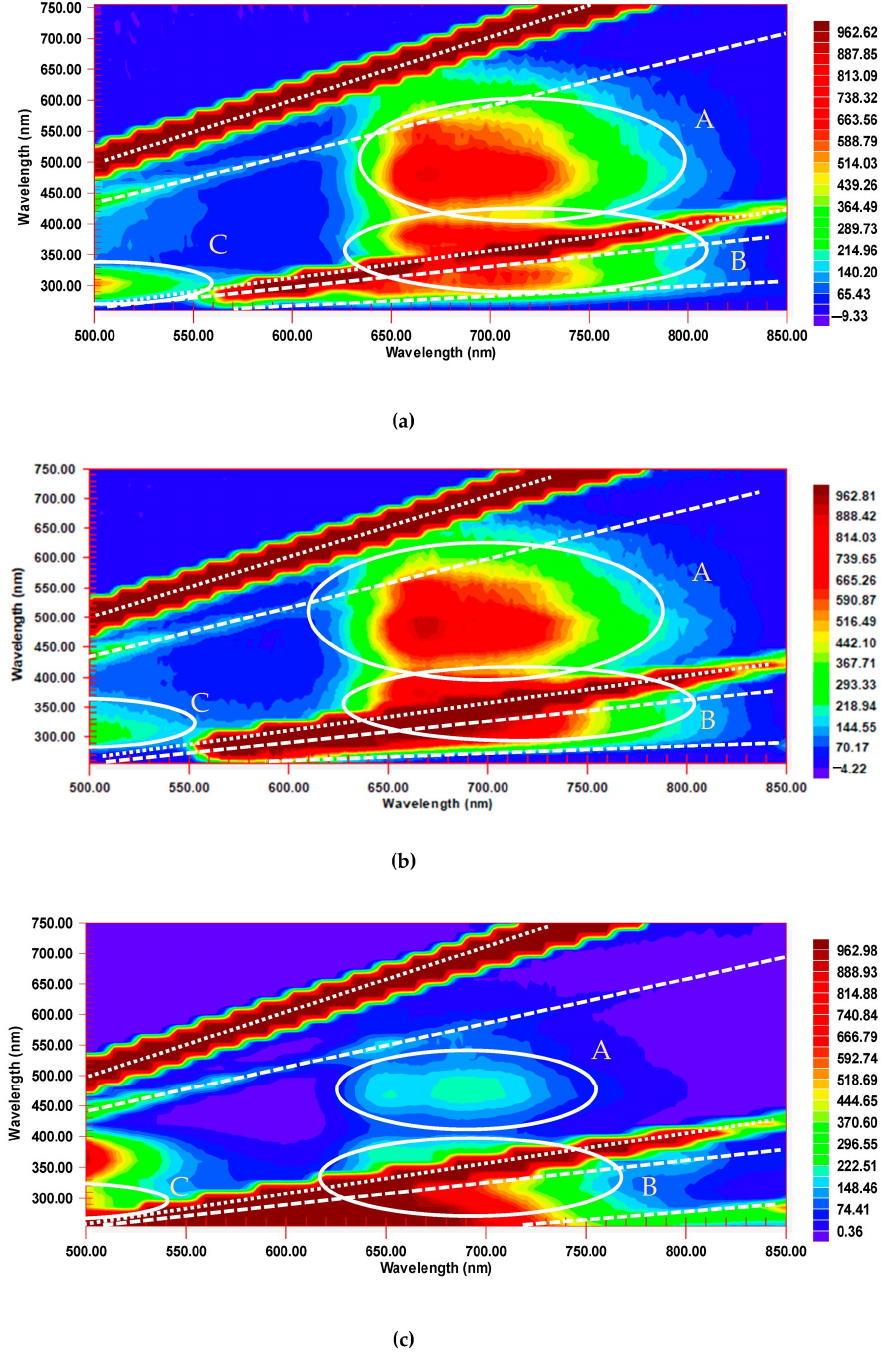
Figure 6. Excitation–emission fluorescence maps of C 70 in ( a ) benzene, ( b ) toluene, and ( c ) n -hexane, 16.3 µM. Excitation/emission slits, 20/20 nm; detector voltage, 870 V; scanning pitch, 15 nm. Y -axis is excitation, X -axis is emission. Regions of fluorescence A, B, and C are marked by white circles. Lines of scattering are denoted by diagonal white lines: 1st-, 2nd-, and 3rd-order Rayleigh (dotted) and 1st and 2nd Stokes Raman (dashed).